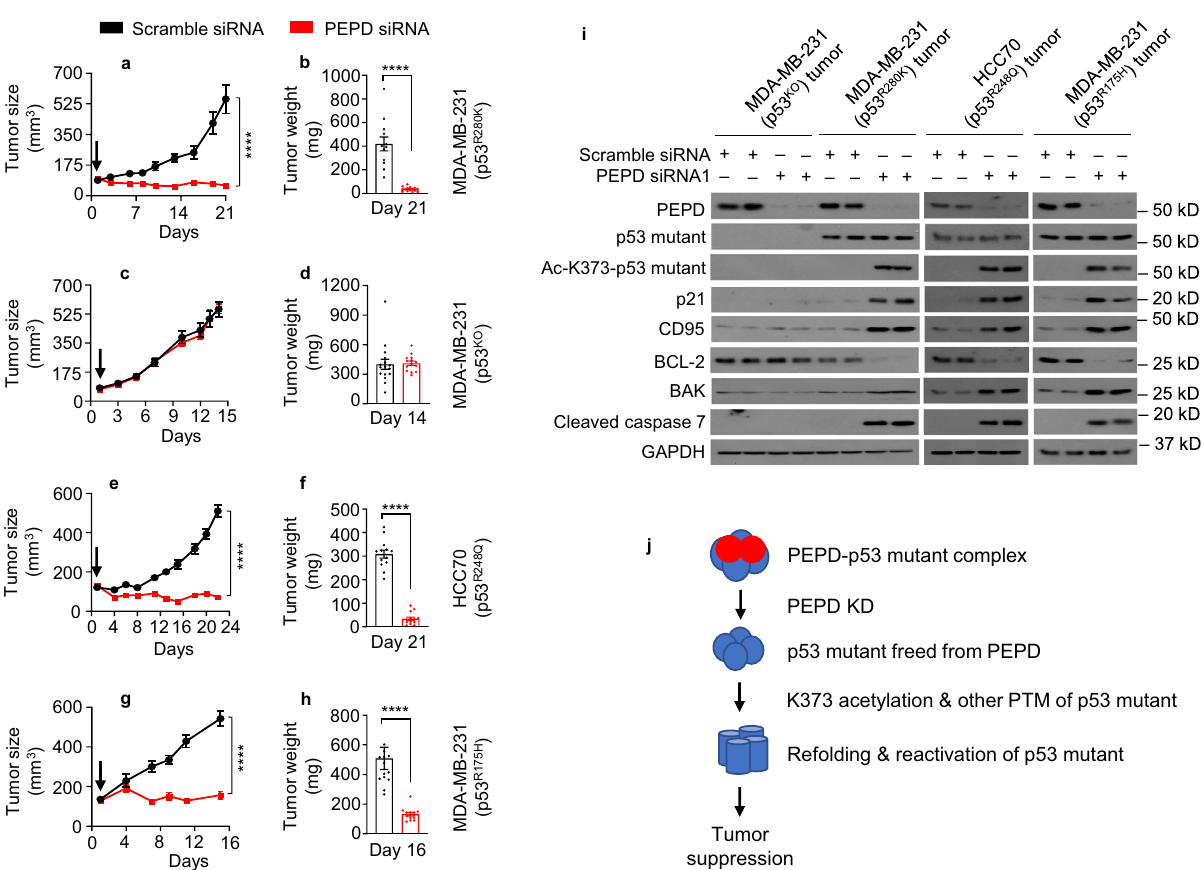
Fig. 10 p53 mutants reactivated by PEPD KD in vivo inhibit tumor growth. a – i Mice bearing orthotopic breast tumors generated from MDA-MB-231 (p53 R280K ) cells, MDA-MB-231 (p53 KO ) cells, HCC70 (p53 R248Q ) cells, or MDA-MB-231 (p53 R175H ) cells were treated by intratumor injection of siRNA (10 pmol) every 3 days. Arrows in a , c , e , and g indicate treatment start. The experiments were stopped 24 or 48 h after the last siRNA dose. Treatment of HCC70 (p53 R248Q ) tumors was suspended for 7 days before the fi nal dose, because the tumors in the PEPD siRNA group became too small to treat. Each value in a – h is mean ± SEM ( n = 13 – 16). The bar plots in b , d , f , and h show individual values and mean ± SEM ( n = 13 – 16). **** P < 0.0001, by paired two- tailed t -test. PEPD and other proteins in tumor homogenates (two tumors per group) were analyzed by WB ( i ). GAPDH is a loading control. j Graphic representation of reactivation of p53 mutants by PEPD KD. A PEPD homodimer binds to a homo-tetramer of p53 mutants. p53 mutants freed from PEPD due to PEPD KD undergo K373 acetylation and other PTM (mono-ubiquitination and phosphorylation), which result in refolding of the mutants and reactivation of their transcription-dependent and transcription-independent tumor-suppressing